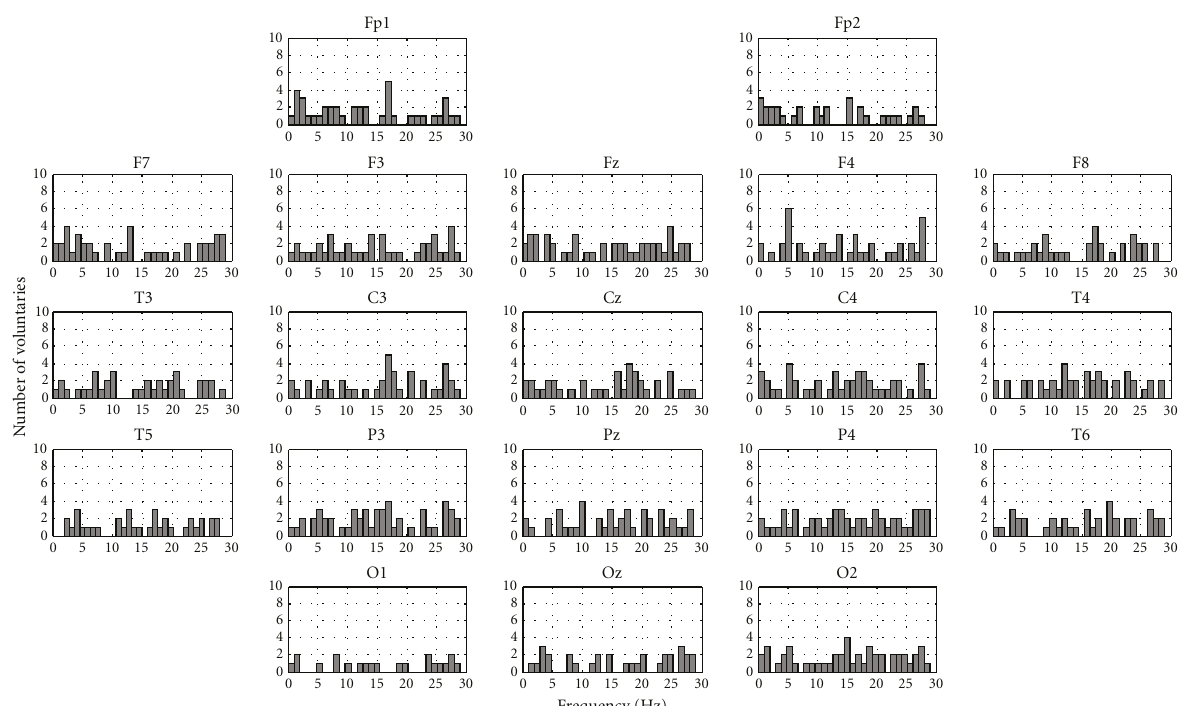
Figure 8: Histogram (bin width 1 Hz) topographic distribution displaying the number of subjects with response after MSC application higher than the critical value (significance level 5%) for spontaneous EEG’s ERPs, with unlighted LEDs, harmonics from 0 to 30 Hz. Frequencies higher than 30Hz did not show significant responses.